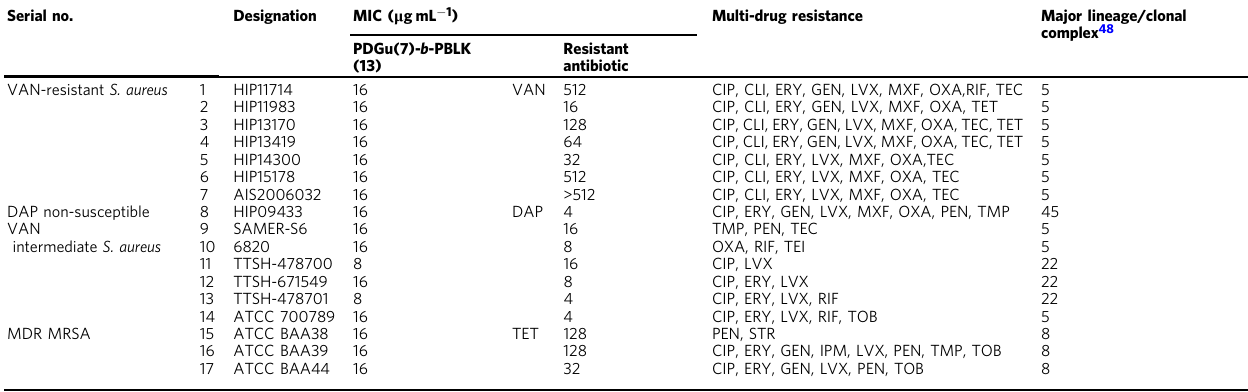
Table 3 Antimicrobial activity against multi-drug-resistant clinically isolated MRSA Serial no.